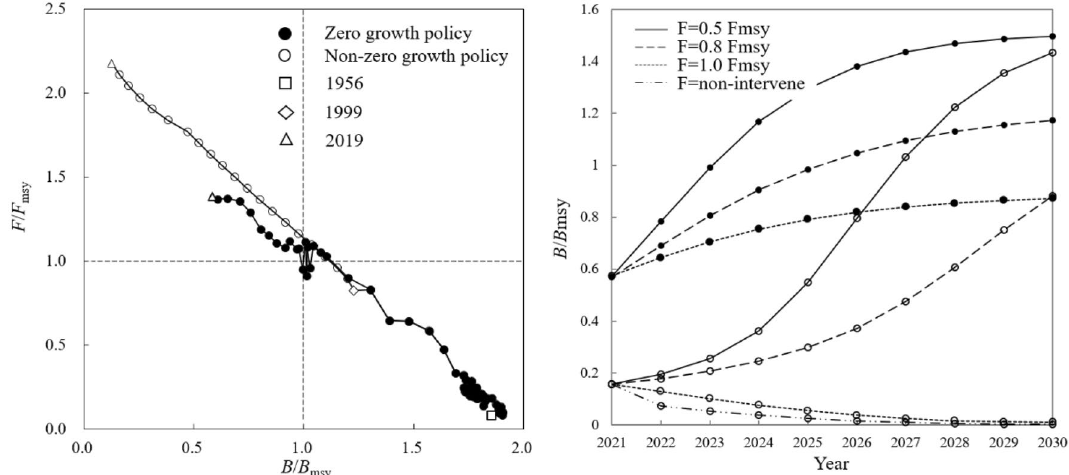
Figure 6. Rebuilding status of Trichiurus spp. Resource status in different quadrants following explanation in Fig. 2.